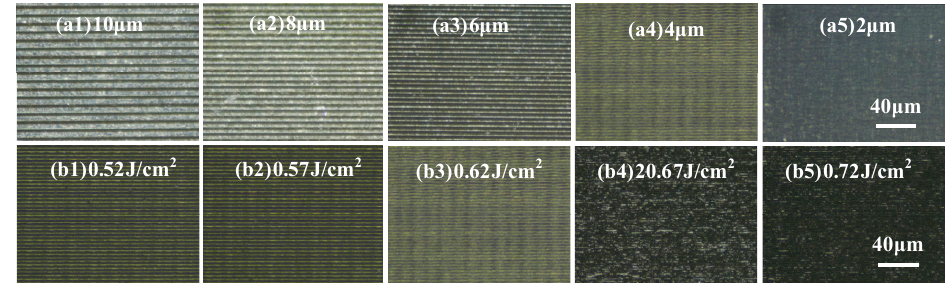
Figure 7. Surface morphology under different polishing parameters: ( a1 – a5 ) Different scanning intervals ( b1 – b5 ) Different laser fluence